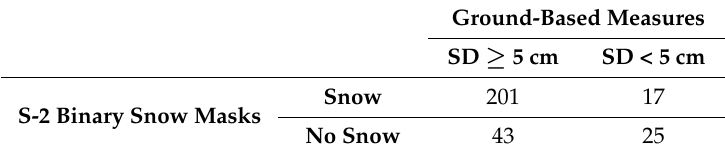
Table 9. Contingency table of ground-based validation of S-2 binary snow maps in Turkey for winter season 2017/18.